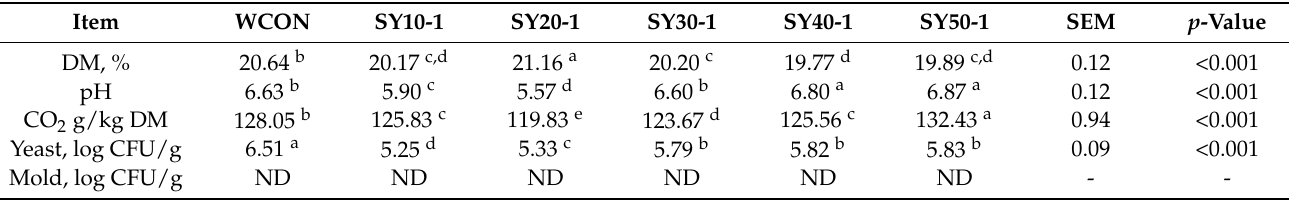
Table 11. Aerobic stability test results of corn